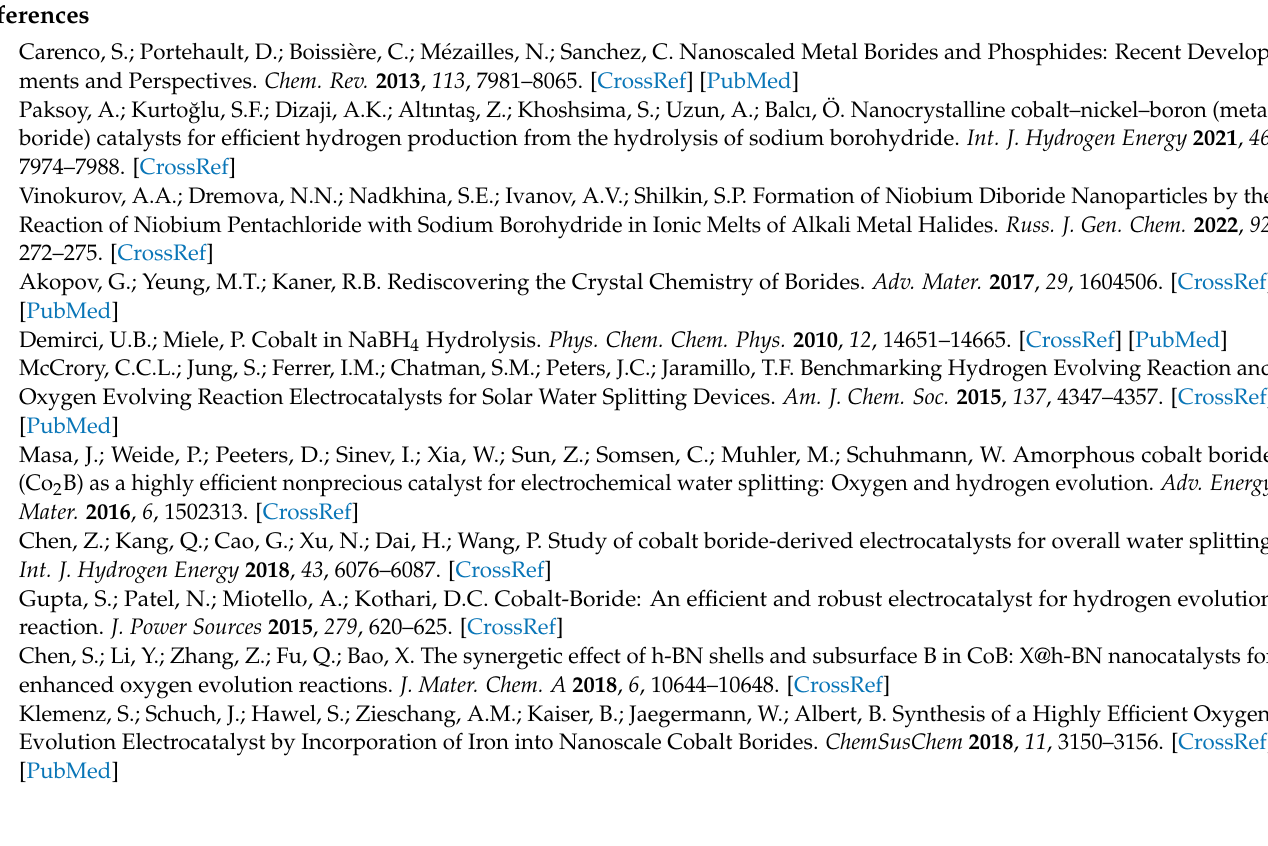
Projection of structure of complex 1 along the a axi; Figure S3, Calculated (black) and experimental (red) X-ray powder diffraction patterns for (a) compound 1 , (b) compound 2 , and (c) compound 3 ; Figure S4, IR spectra of (a) complex 2 · n H 2 O (blue), sample 2a (green) and amorphous boron (red)); Figure S5, Fragments of IR spectra of complex 1 (blue), sample 1a (purple) and amorphous boron (red); Figure S6, Fragments of IR spectra of complex 3 (purple), sample 3a (red) and amorphous boron (green); Figure S7, X-ray spectral fluorescence spectrum of sample 3a : (A) determination of Cl, (B) determination of